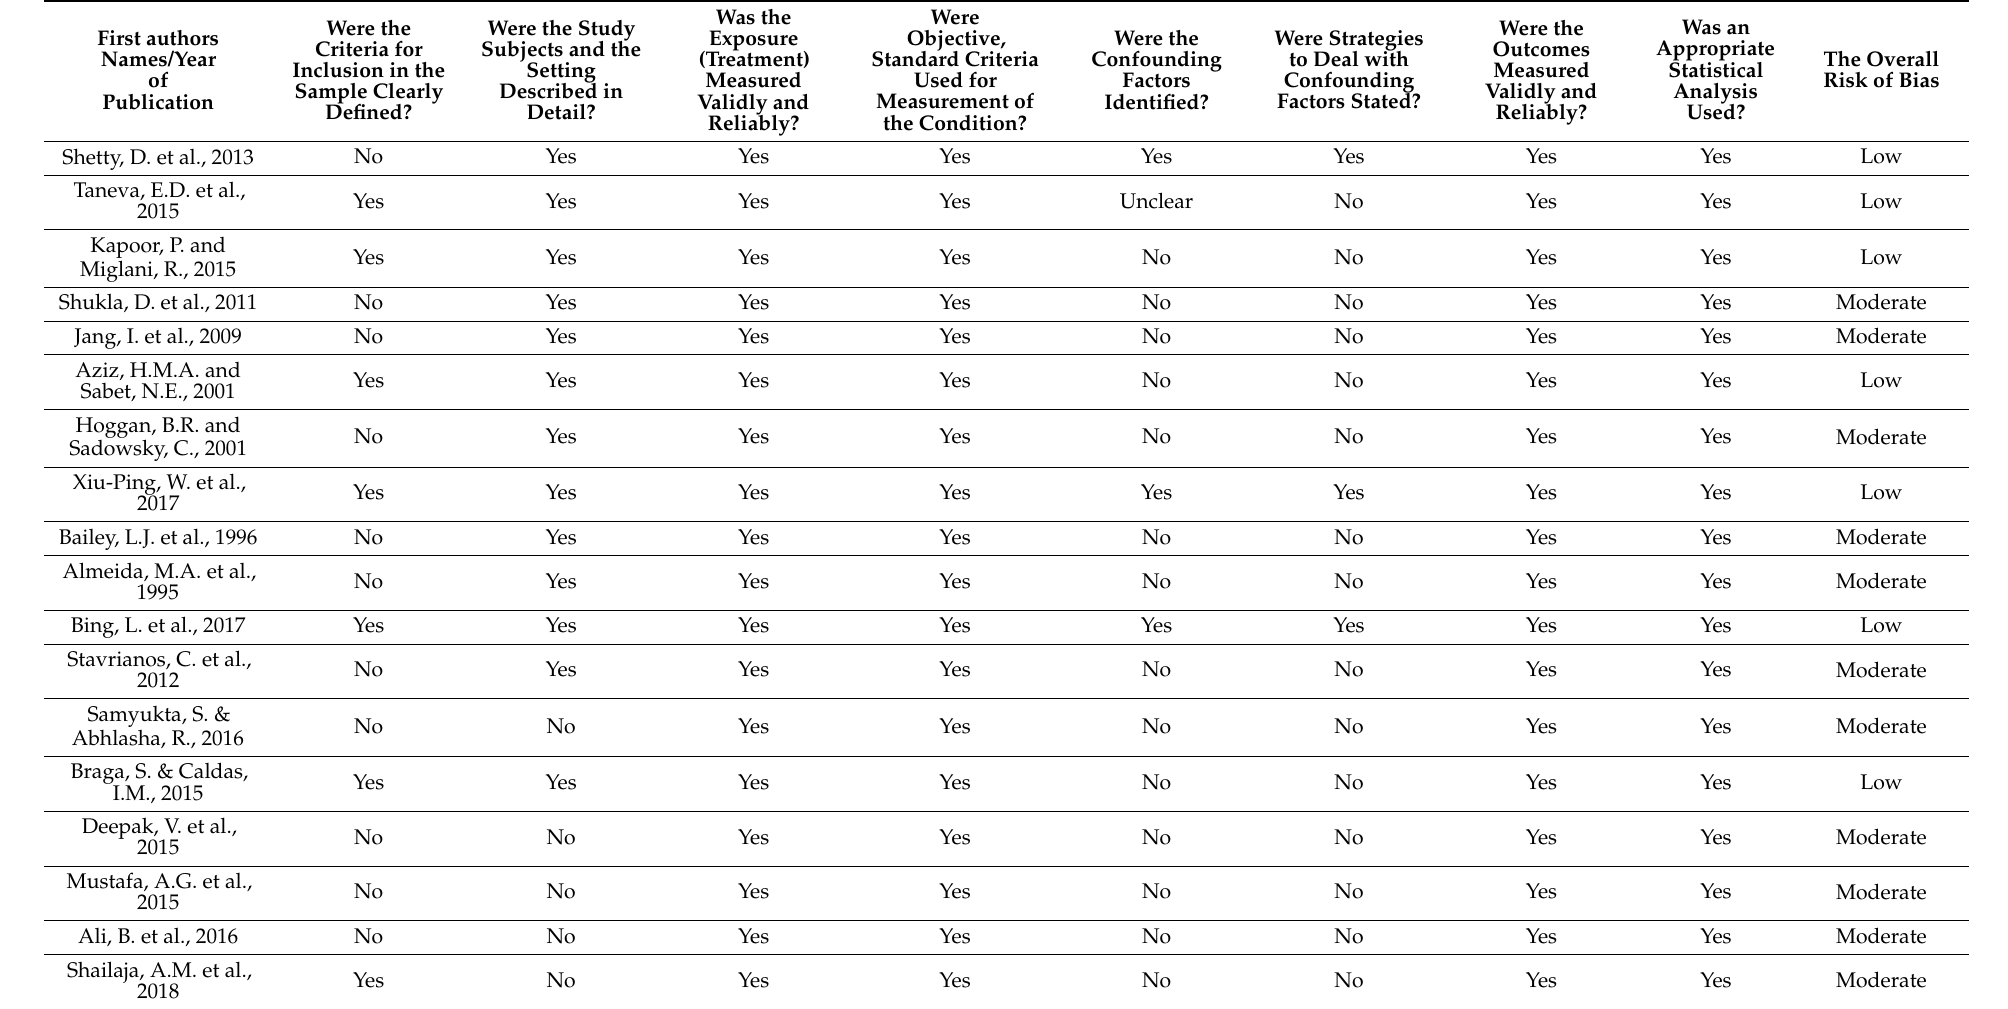
Table 2. Joanna Brigg’s risk of bias assessment of the included